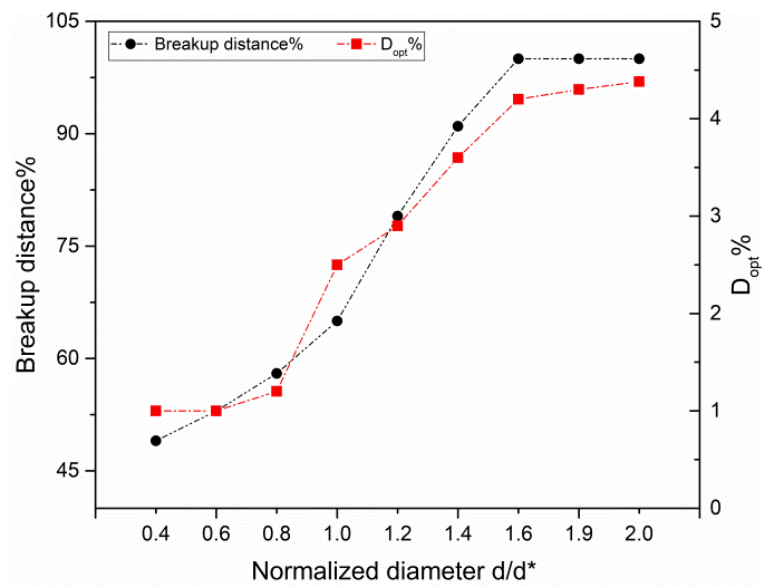
Figure 8. The optimum condensation distance and breakup distance for